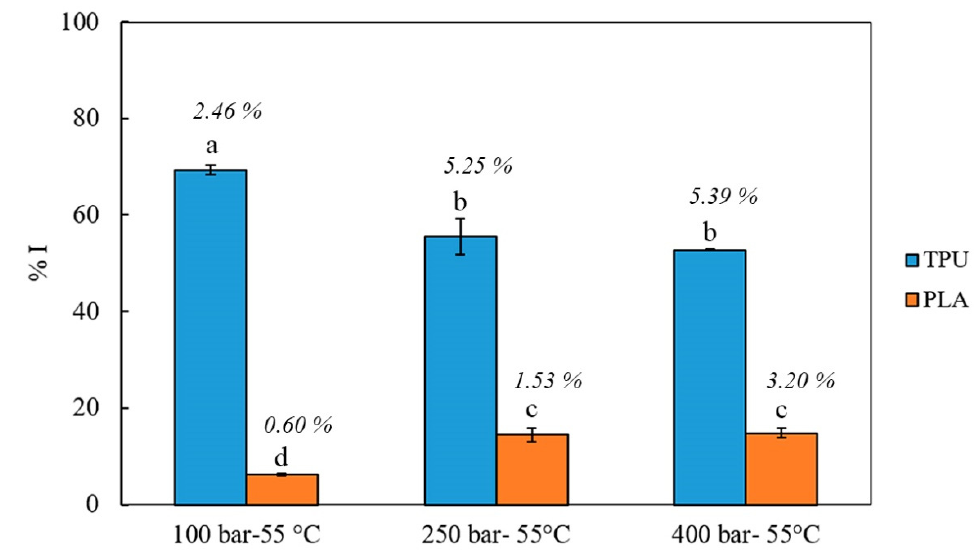
Figure 8. Percentages of oxidation inhibition (%I) for OLE-loaded polymer filaments impregnated under supercritical conditions (100, 250 and 400 bar and 55 ◦ C, n = 2). Letters show statistical differences among samples (Tukey test, α = 0.05). Percentage values at the top of the columns indicate %OLE loading at each condition.